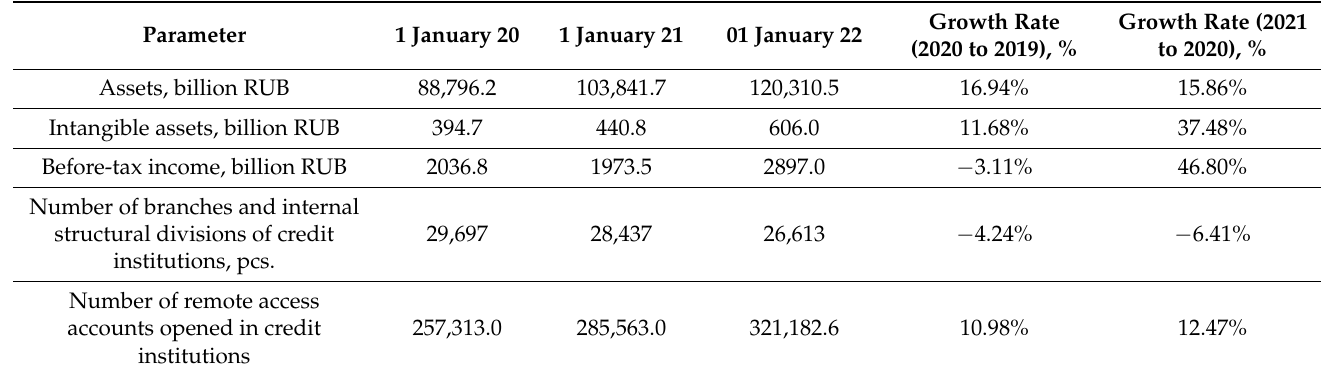
Table 4. Dynamics of performance indicators of credit institutions in